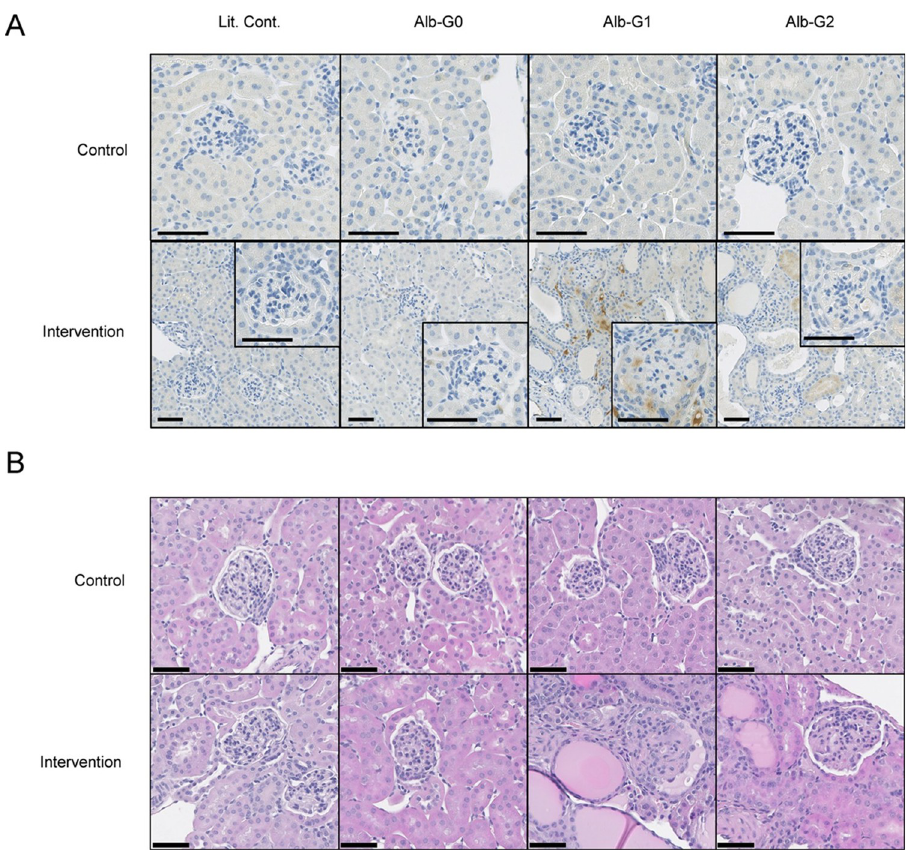
Fig 3. Circulating risk variant APOL1 and pathological changes. (A) Circulating APOL1 protein localizes to injured kidneys. To induce kidney damage and proteinuria in Alb/APOL1 mice (Alb-G0, Alb-G1, and Alb-G2) and their non- transgenic littermate controls (Lit. Cont.), mice received interferon- γ , puromycin, and basic fibroblast growth factor. Immunohistochemical detection of APOL1 protein in kidney from Alb/APOL1 mice after kidney-damaging intervention is shown compared with their littermate controls and non-treated control animals. Risk variant APOL1 protein localized to the kidney in Alb/APOL1-G1 mice and to a lesser extent in Alb/APOL1-G2 mice. Scale bars are 25 μ m. (B) Circulating risk variant APOL1 is associated with pathological changes in the triple intervention model. Hematoxylin and eosin staining of kidney from Alb/APOL1 mice with and without the triple intervention demonstrated pathological differences in kidneys from treated mice that have circulating APOL1-G1 and APOL1-G2. Scale bars are 50 μ m.